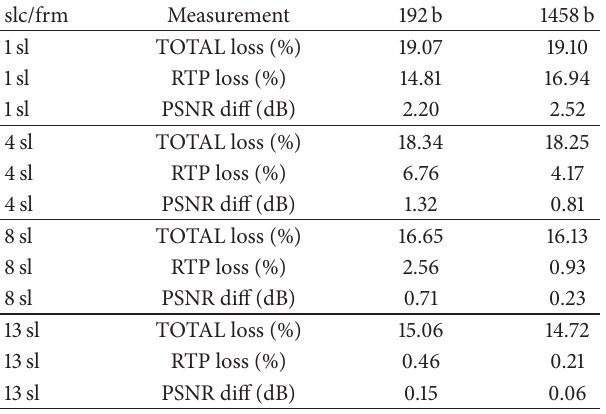
Table 5: Total percentage of network packet loss, percentage of RTP packet loss after recovery and difference in PSNR of the reconstructedvideo,forabackgroundtrafficof390 ppsandalevelof protection of 30%, for areas with good signal coverage. AI encoding